Question: Does the figure show an increasing or a decreasing trend?
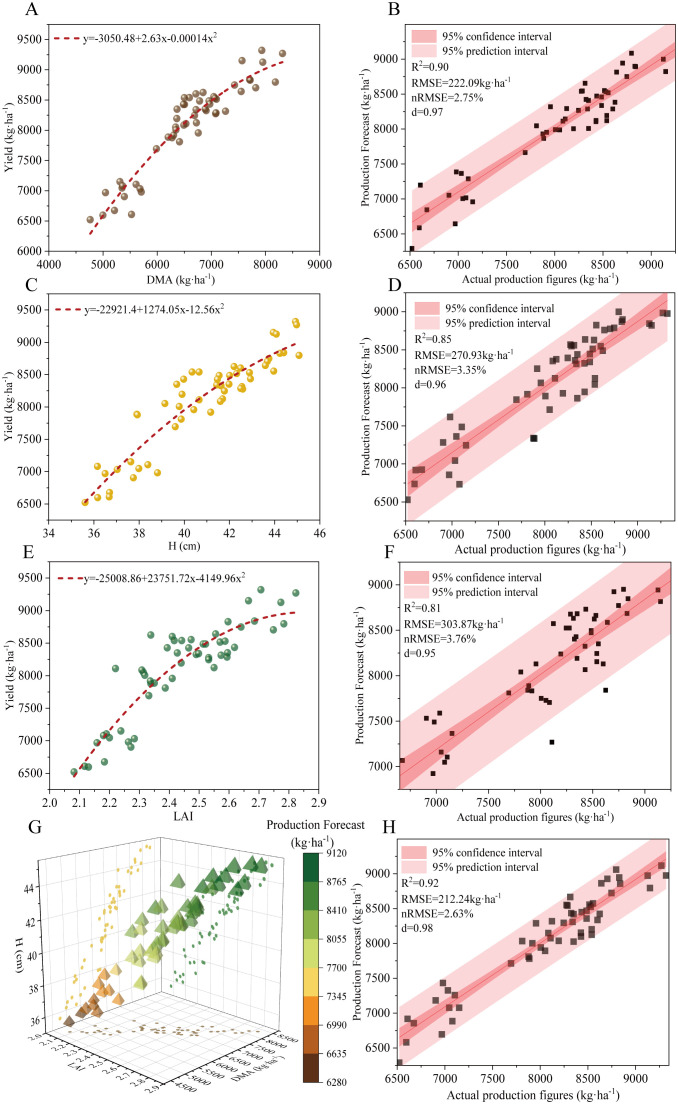
Answer: increasing